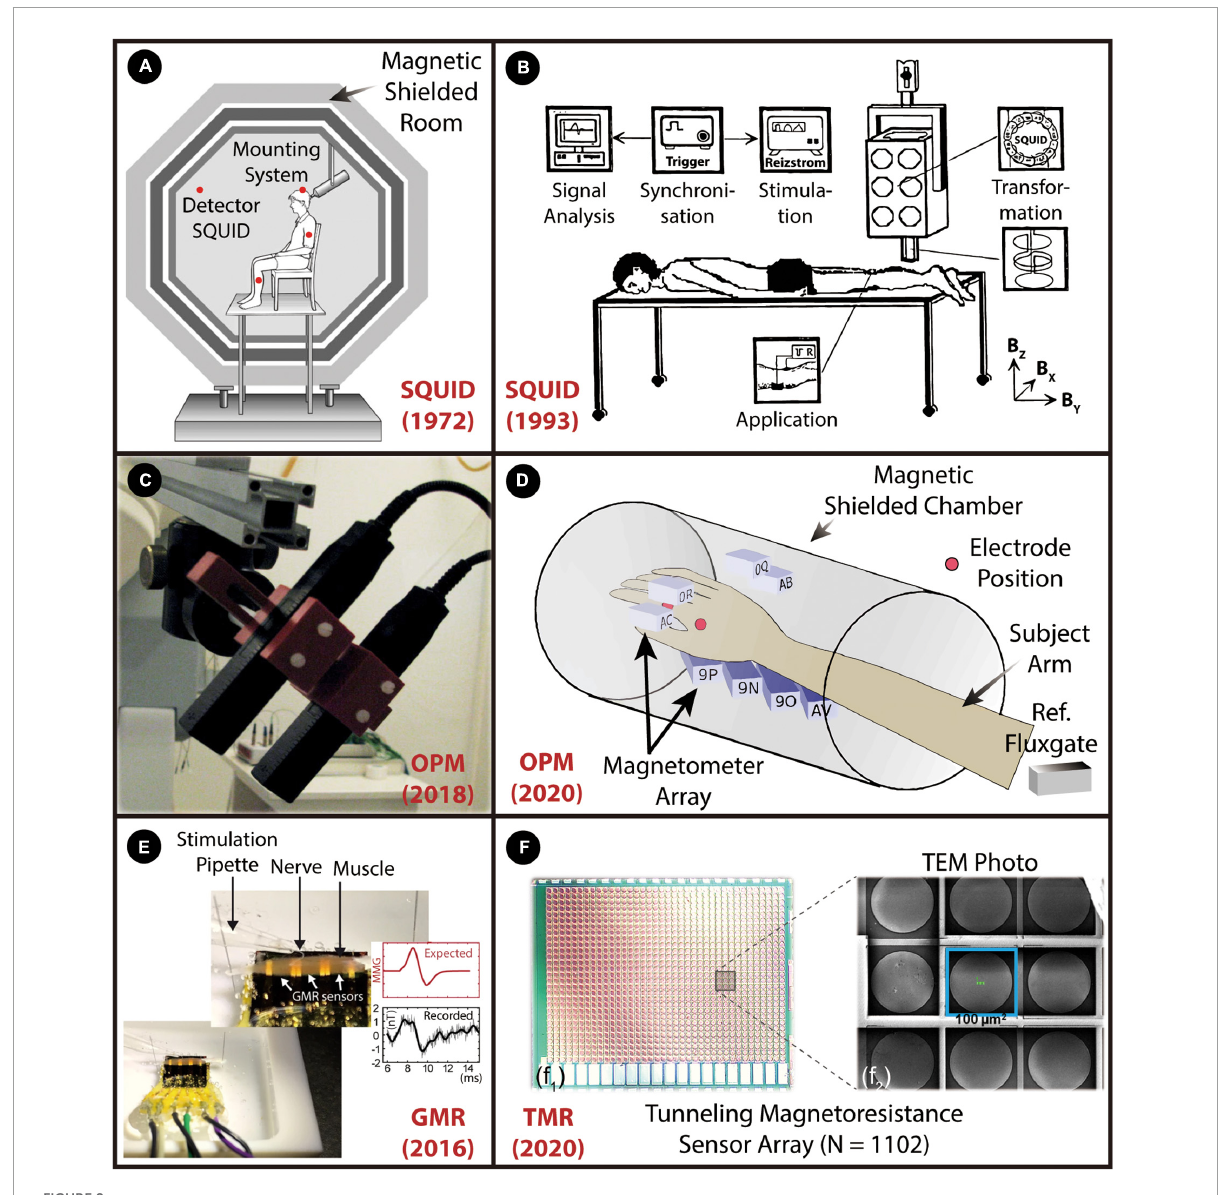
FIGURE8 A graphical overview of the weak MMG detection from skeletal muscle. The figure shows the miniaturization pathway from bulky SQUIDs to spintronic nanoscale sensors. (A) SQUID magnetometer. Reproduced with permission (Cohen and Givler, 1972). Copyright 1972, Elsevier (B) , Room SQUID system. Reproduced with permission (Reincke, 1993). Copyright 1993, Biomed Tech (Berlin), (C) OPM based on the zero-field resonance of spin-polarized rubidium atoms in. Reproduced with permission (Broser et al., 2018). Copyright 2018, IEEE, (D) OPM array. Reproduced with permission. (E) Spintronics sensor based on GMR effect. Reproduced with permission (Barbieri et al., 2016b). Copyright 2016, Springer Nature, (F) TMR sensor array with 1102 TMR elements are connected in 38 series and 29 parallel. Reproduced with permission